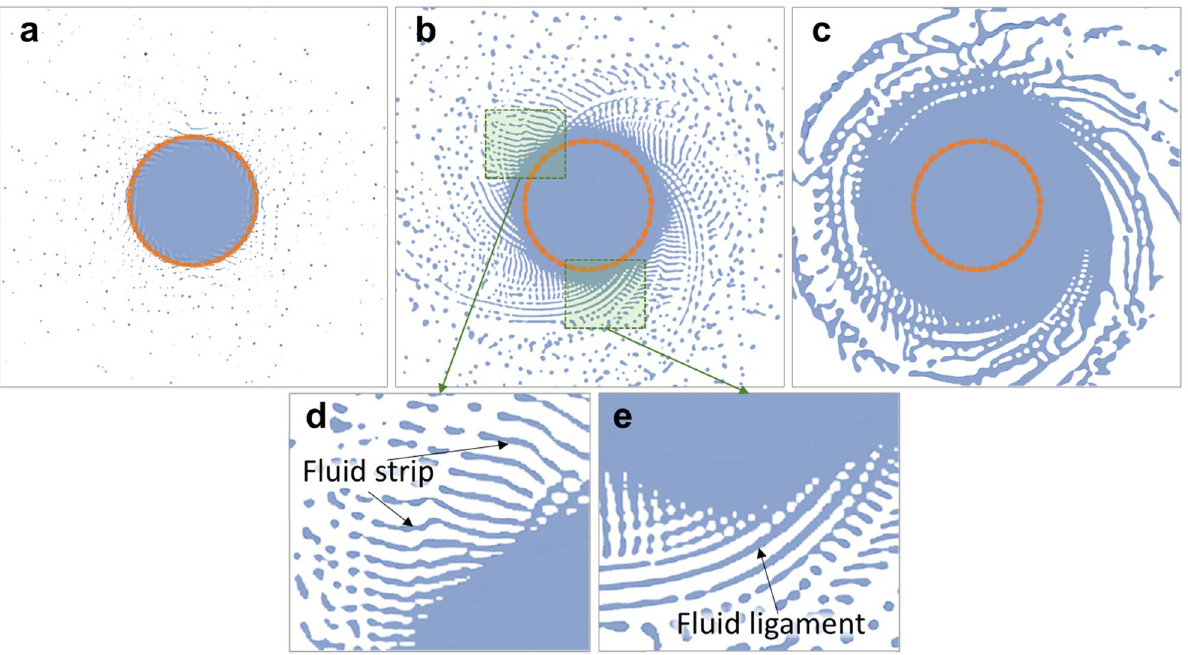
Figure 15. CtFD-simulated the PREP process of Ti64 with an electrode diameter of 15 mm and a rotating speed of 7000 rpm. The melting rates in the simulations were set to ( a ) 2.5 × 10 –7 , ( b ) 1 × 10 –6 , and ( c ) 7.5 × 10 –6 m 3 /s. The corresponding disintegration modes are ( a ) DDF, ( b ) transition from DDF to LF in which ( d ) fluid strip and ( e ) ligament were observed, and ( c ) transition from LF to